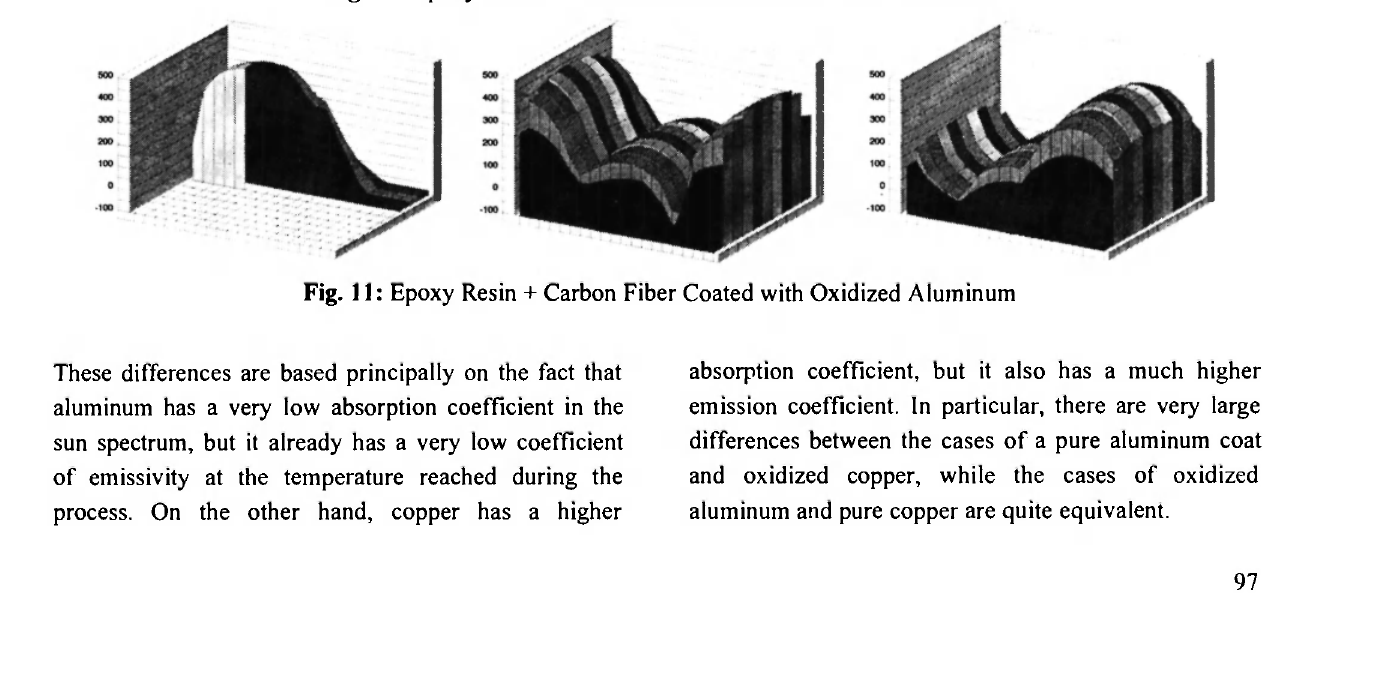
Fig. 10: Epoxy Resin + Carbon Fiber Coated with Pure